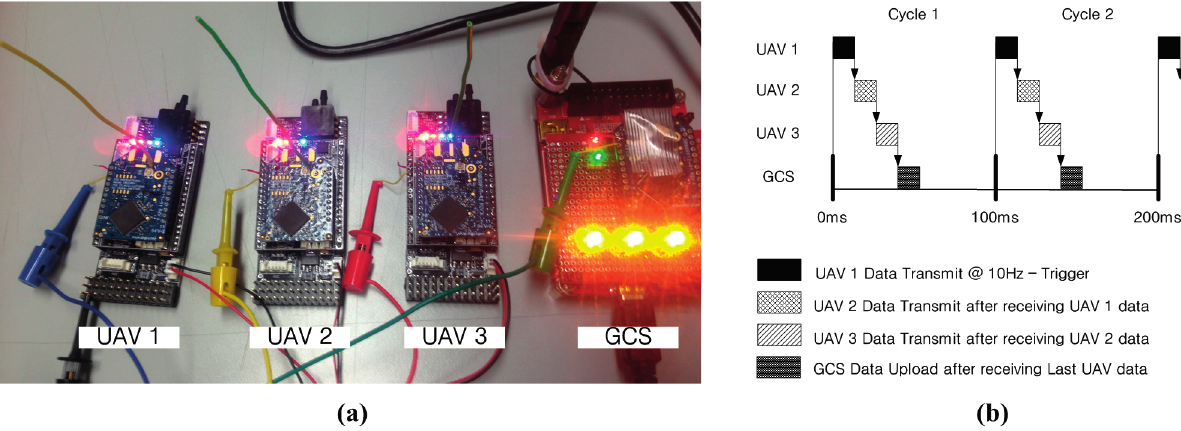
Figure 7. ( a ) Embedded FCCs and GCS; ( b ) sequential cyclic